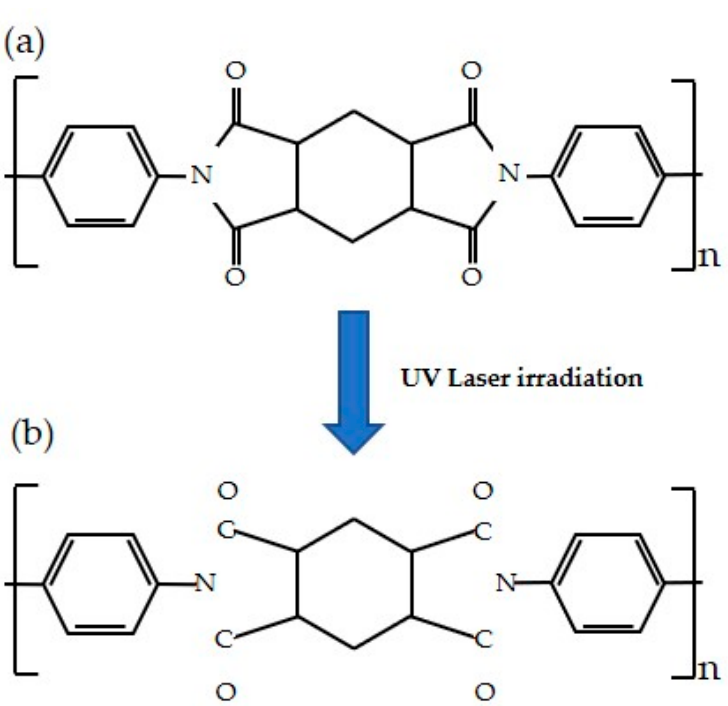
Figure 2. Principle of laser-induced graphene (LIG). ( a ) Structure of polyimide film; ( b ) Structural change of polyimide film after laser irradiation.